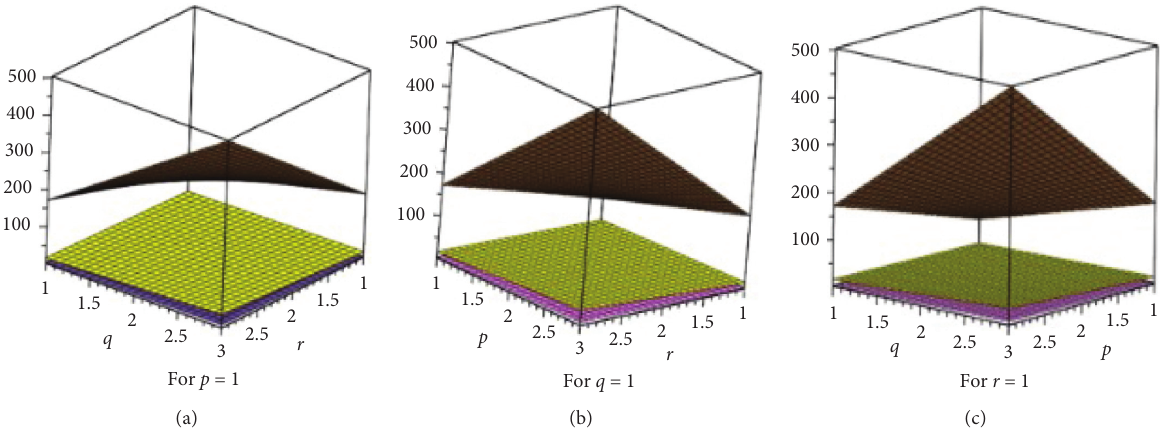
Figure 7: Comparison of IRL , IRD